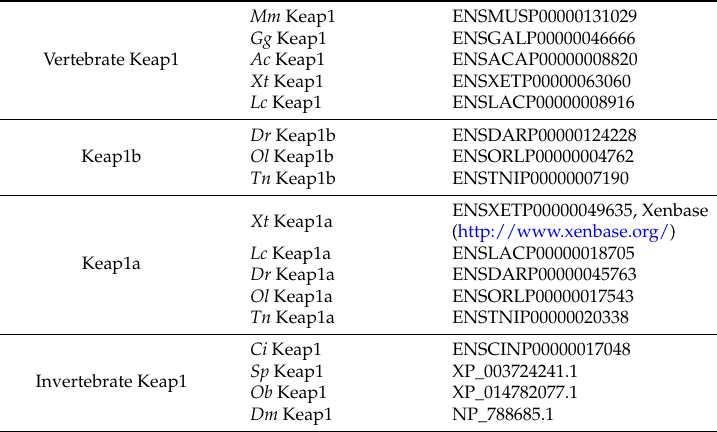
Table 2. Summary of Keap1 proteins.